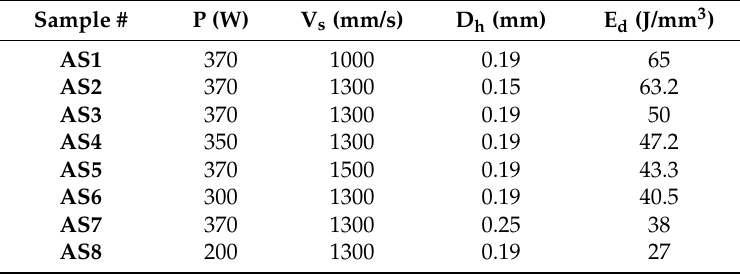
Table 1. The selective laser melting (SLM) process parameters used for building the AlSi10Mg